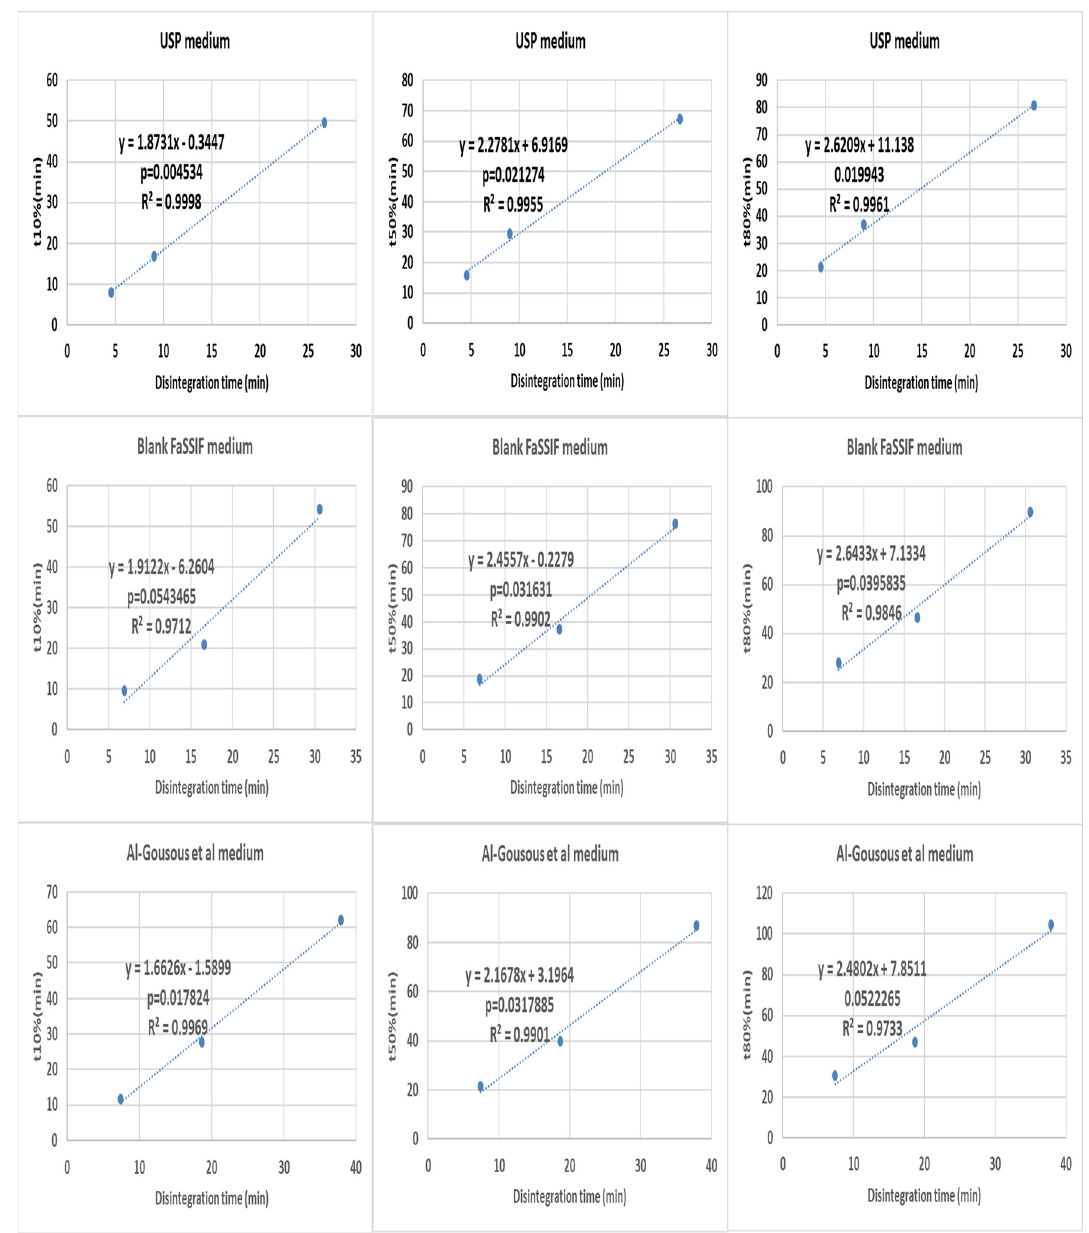
Figure 6. Correlating disintegration times with different dissolution (paddle apparatus) parameters for different formulations tested in one medium. The p -value is a one-sided value for a t -test applied to the slope.